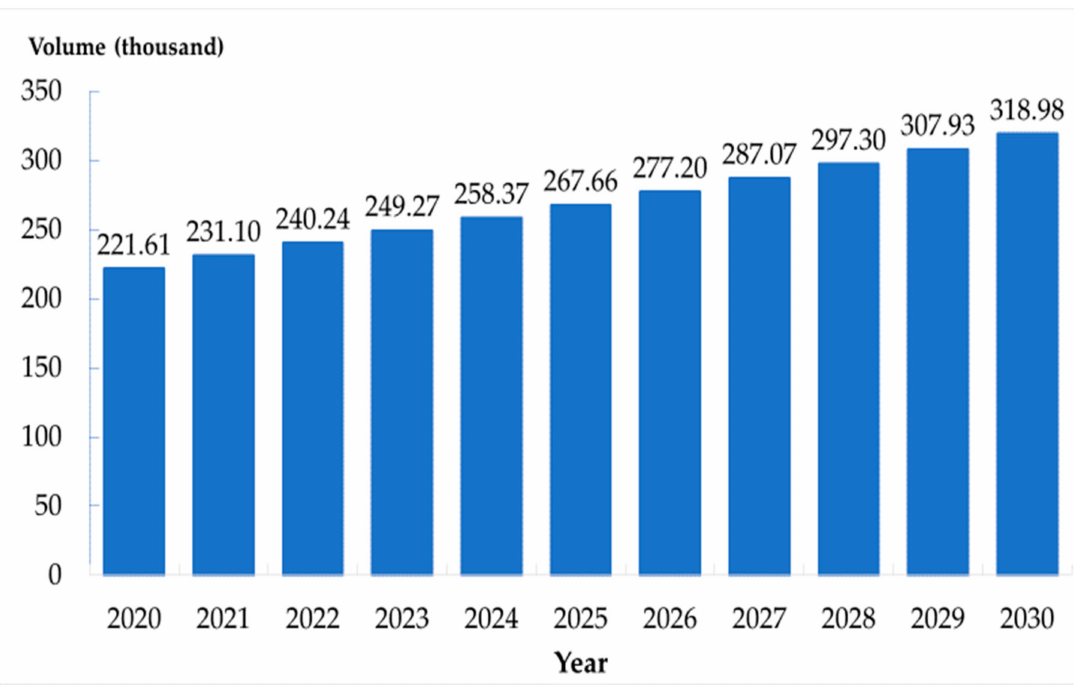
Figure 3. Number of the elderly in home group in Thailand,